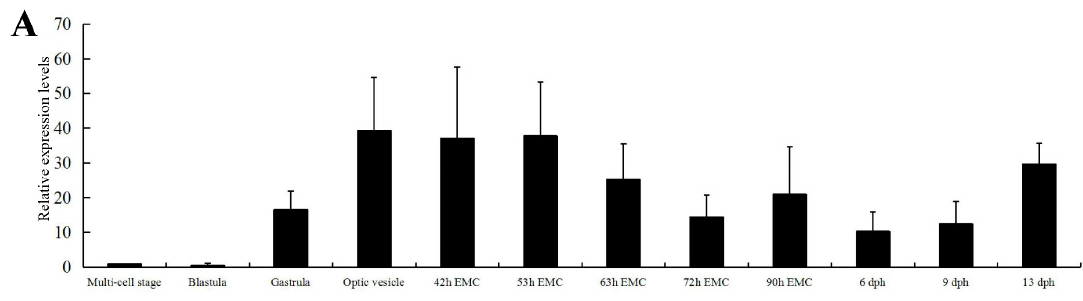
Figure 3. Cont . Figure 3. Cont